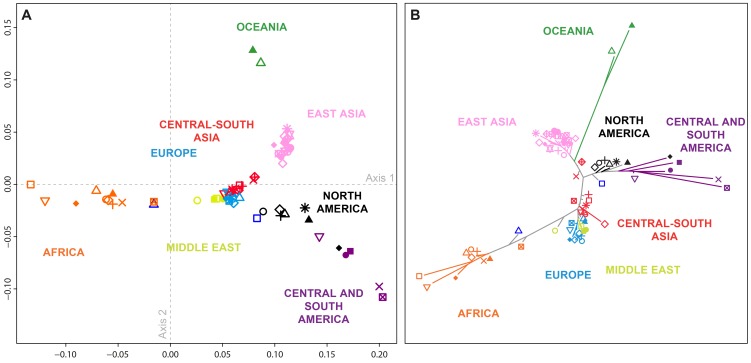
Population-level population structure for 71 populations.Shown are a (A) multidimensional scaling (MDS) plot (Spearman ρ = 0.965; P<10−15, comparing population-pairwise Euclidean distances on the two-dimensional MDS plot to their population pairwise F
ST values), and (B) Neighbor-joining tree based on population pairwise F
ST. All the edges of the tree were supported by 100% of the 1,000 bootstrap replicates performed except for four edges corresponding respectively to the Kalash, Caucasian (CEU), Orcadian, and French populations (supported by 76%, 75%, 75%, and 74%, respectively, of the 1,000 bootstrap replicates). Population colors and symbols follow Figure 1.